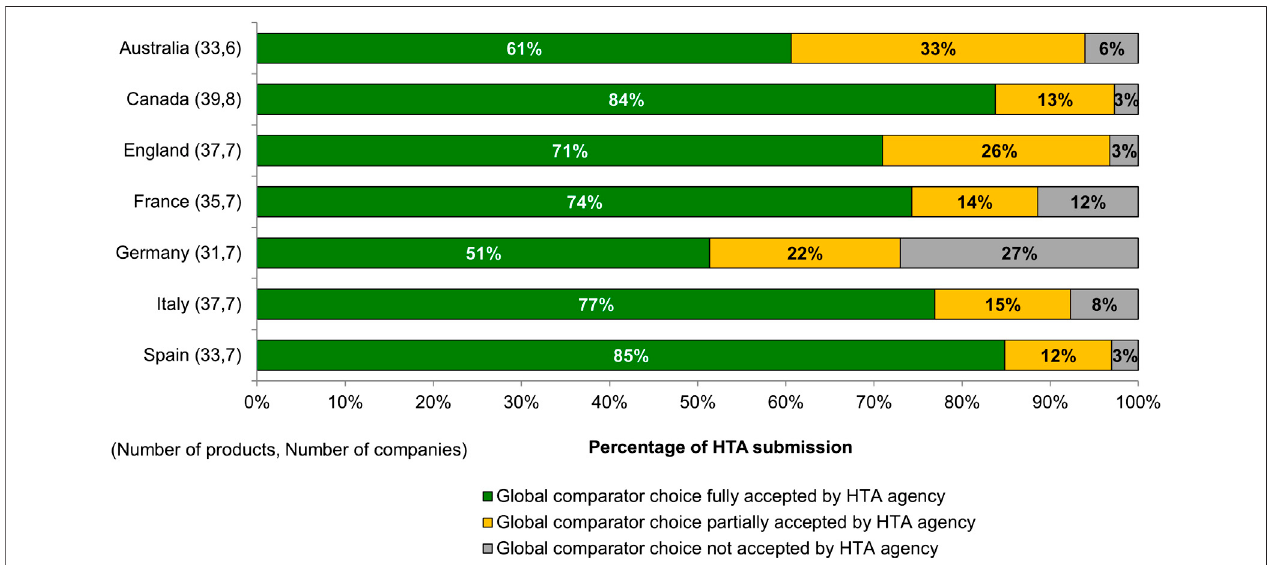
FIGURE 1 | Acceptability of companies ’ selectison of comparators in global clinical